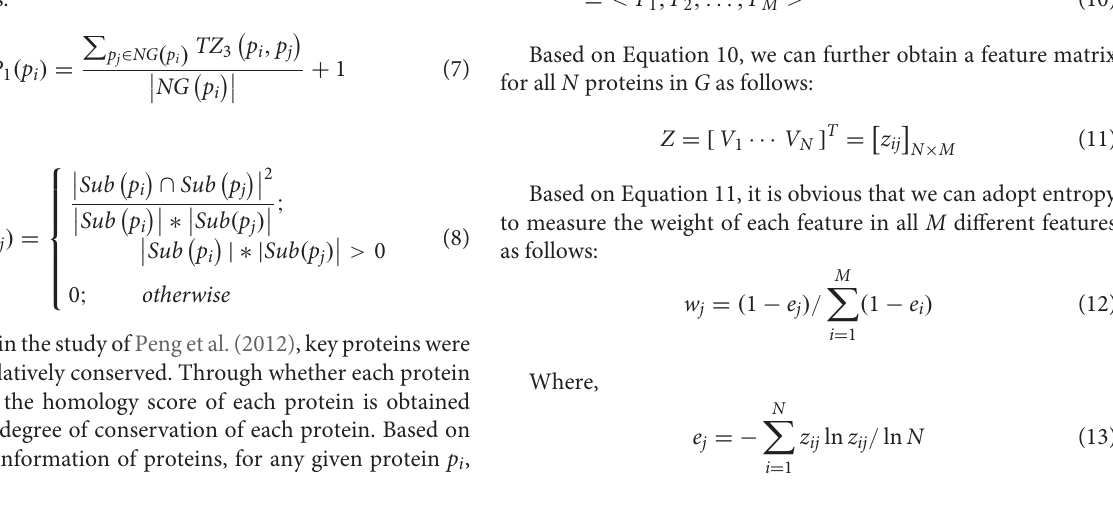
TABLE 1 | A brief description of the existing representative prediction models.